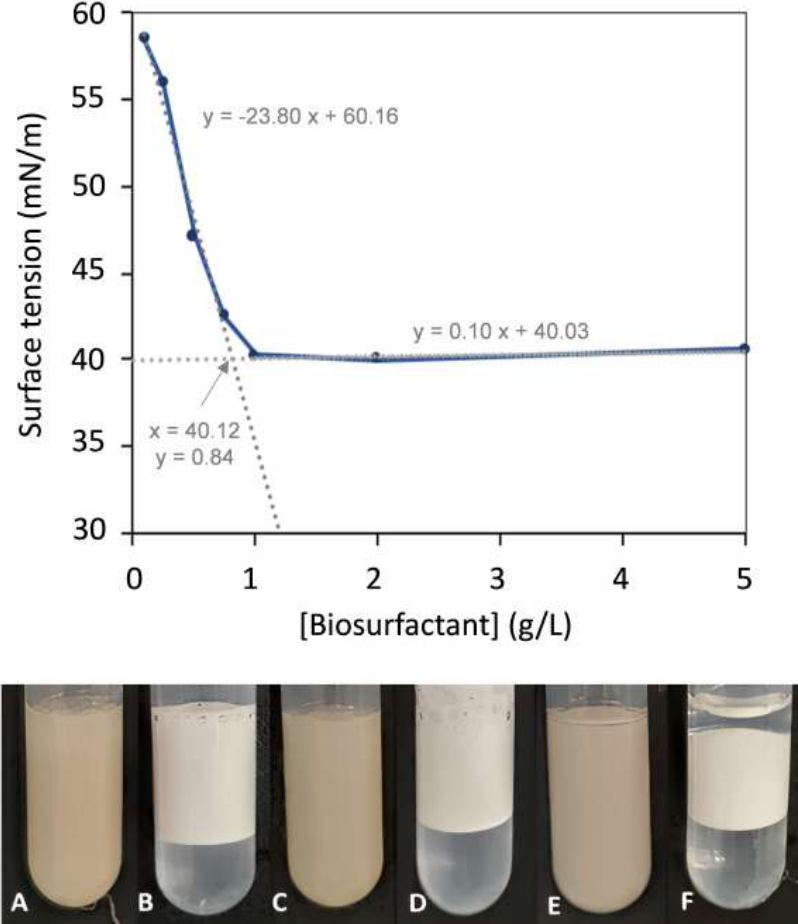
Figure 3. Surface tension of B. thailandensis biosurfactant solutions at concentrations ranging from 0.1 to 5.0 g/L and images of the biosurfactant’s emulsions with almond oil ( A ), sunflower oil ( C ), and benzene ( E ), after standing for 24 h. The chemical surfactant Triton X-100, at the same concen- tration, was used to prepare emulsions with the same hydrophobic compounds ( B , D , F , respectively) for comparison.